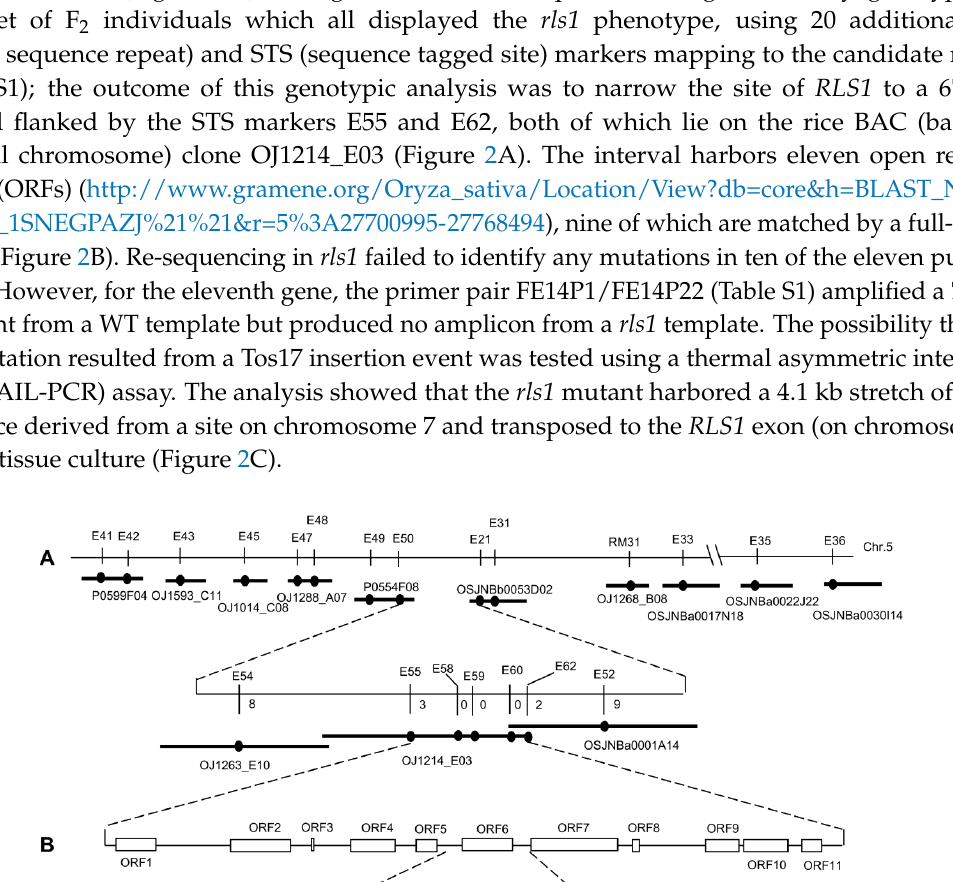
interval harbors eleven open reading frames (ORFs)